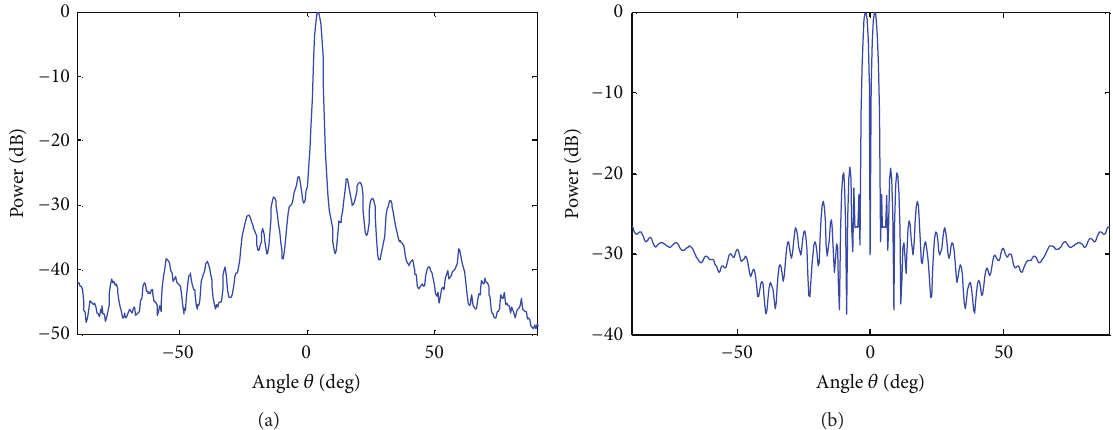
Figure 12: (a) The sum pattern and (b) difference pattern of measured cassegrain antenna at 9 GHz (normalized